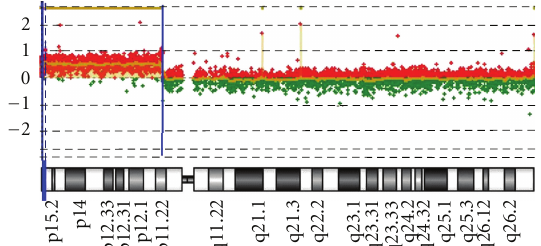
Figure 2: Oligonucleotide-aCGH profile for chromosome 10. The ideogram (lower part) depicts the entire chromosome 10. The 33Mb gain interval at 10p11.22p15.3 [hg18,chr10: 0-33,408,955 bp] detected in this patient is indicated by two vertical blue bars, and the log 2 ratio of